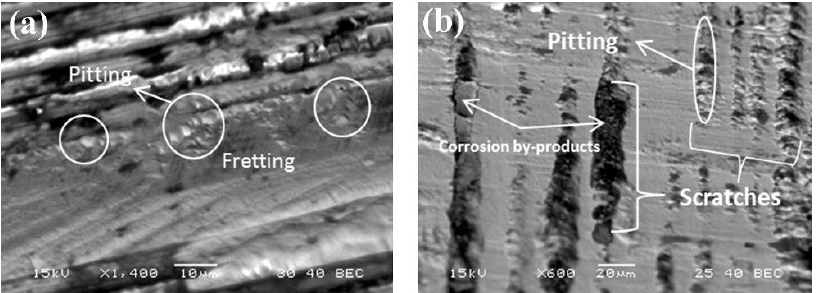
Figure 33. ( a ) The metal taper of a retrieved hip implant revealing pitting corrosion (marked in white circles) initiated preferentially in a crevice formed due to fretting abrasion (5–40 µ m scratches). This damage was imaged midway between proximal and distal ends on the taper. ( b )A different component showing scratches (50–500 µ m) throughout head taper, with preferential pitting inside the scratches, imaged midway between the proximal and distal ends on the taper. Corrosion by-products (biological and electrochemical deposits) accumulated inside the scratches [353]. Reprinted with permission of Elsevier.